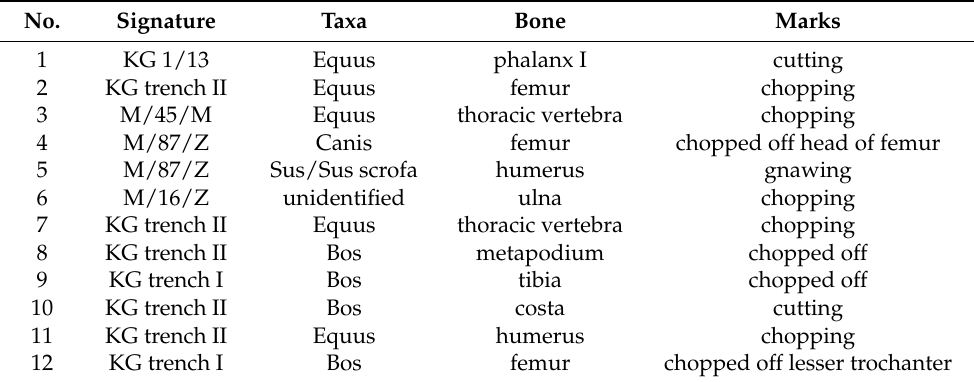
Table 8. The summary of bone marks identified in animal skeletal remains from Kamienna G ó ra and Złotoryja